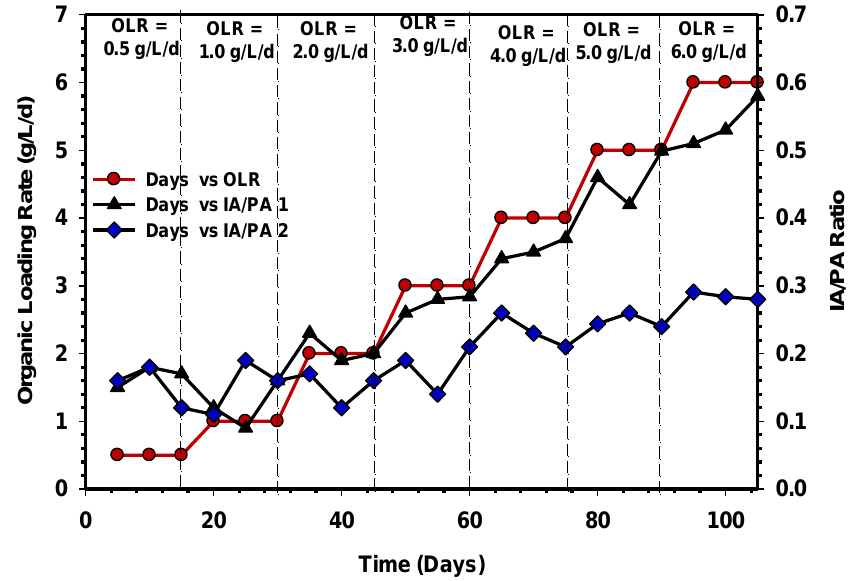
Figure 9. Variation of IA/PA ratio of UASB 1 and 2.